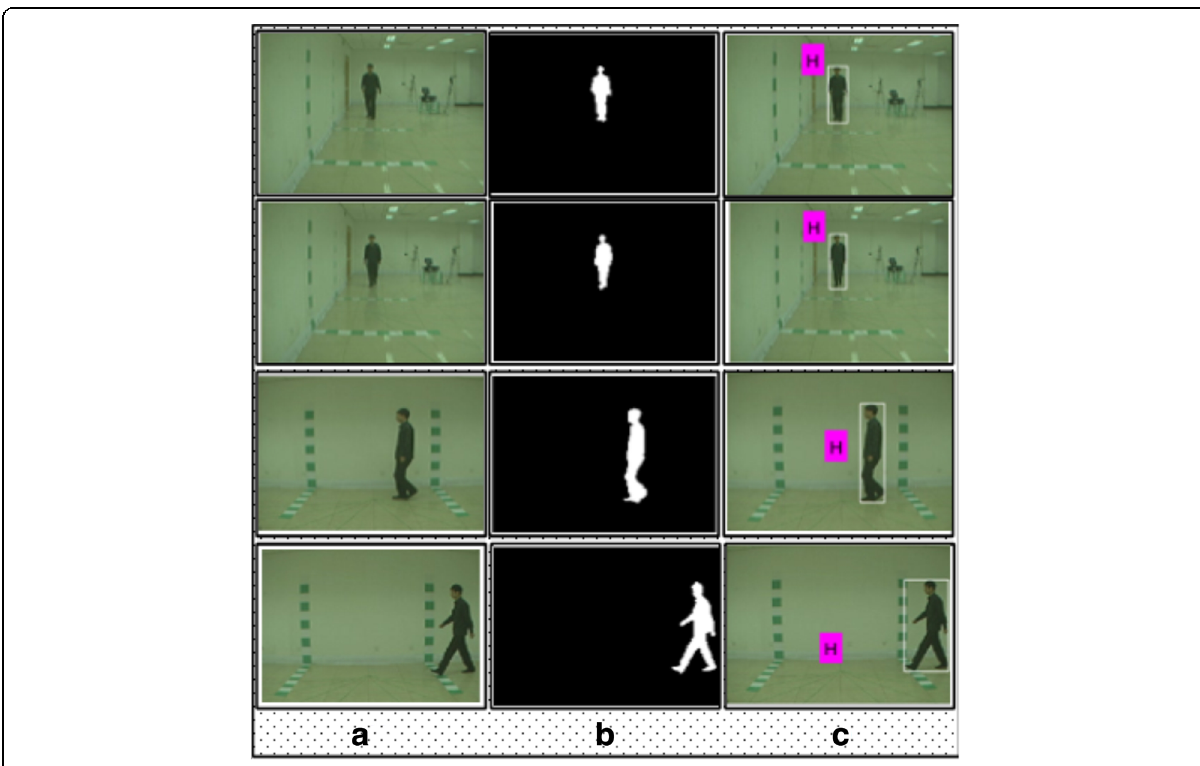
Fig. 10 Classification results for CASIA